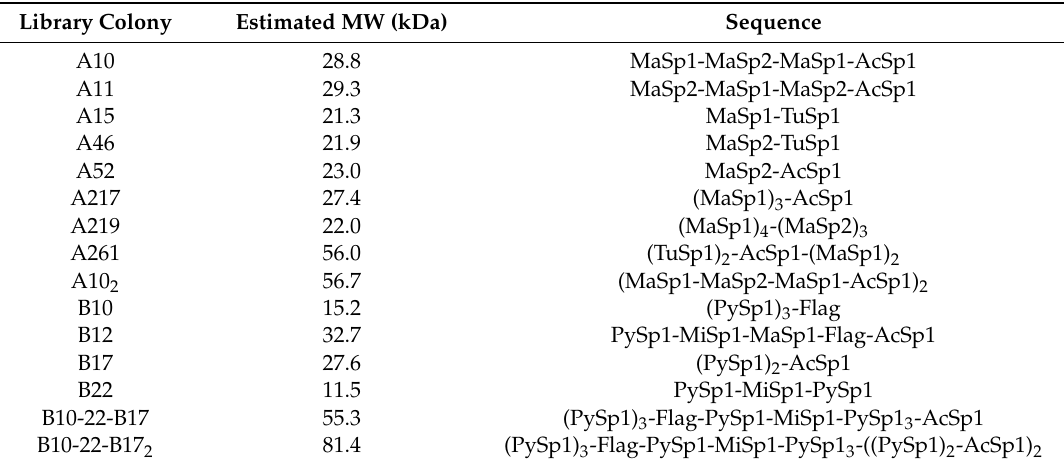
Table 2. Summary table of relevant library colonies obtained from screening with molecular weights determined by primary sequence data and the corresponding gene